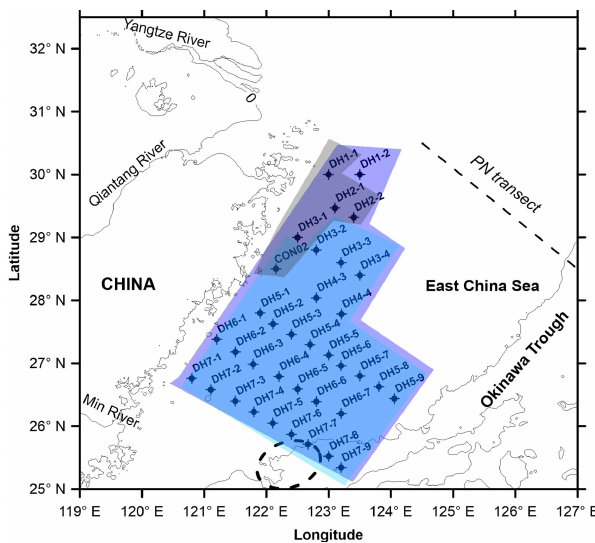
Figure 7. A diagram delineating the regions influenced by three main water masses based on the T – S relationship (Figs. 2 and 6) in the study area. Area with grey polygon represents the influence of CDW, which is limited only in the upper 10m. The sky-blue area represents the dominance of TWCW, which is limited to ∼ 30m below the surface. The polygon coloured by deep blue represents the area influenced by the KSSW, indicating that the bottom water of the entire study area was dominated by